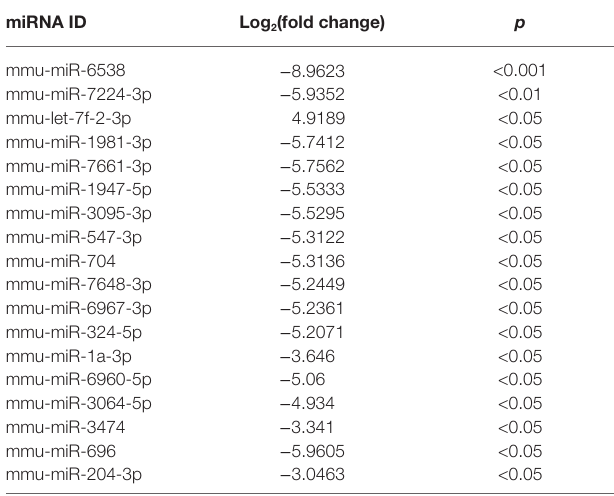
TABLE 2 | Differentially expressed miRNAs in EVs from HG-podo group compared to MA-podo group.